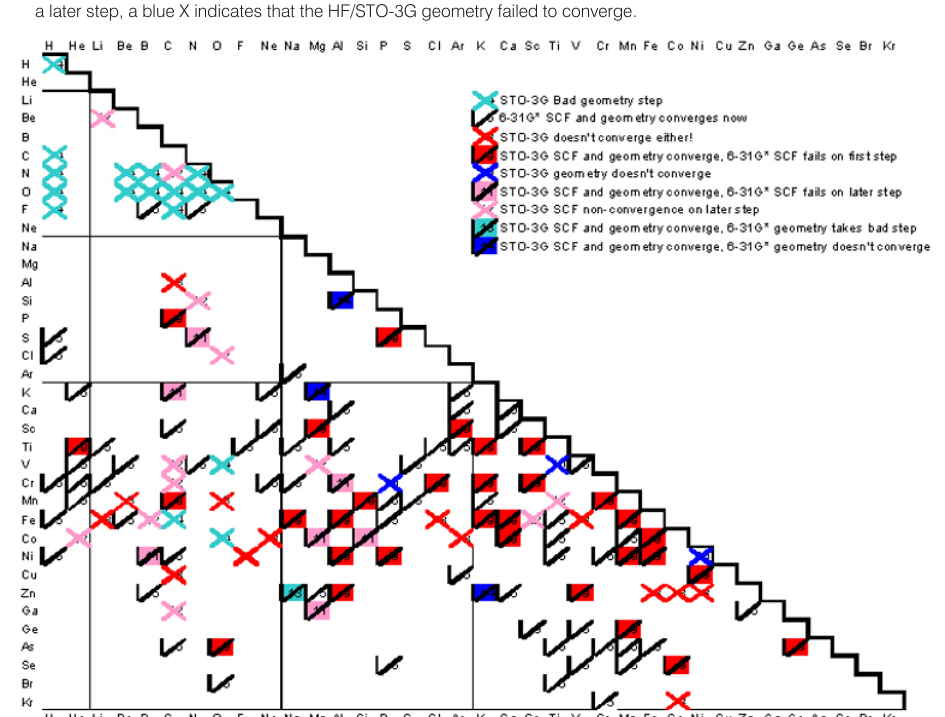
Figure 4. Results of running HF/STO-3G optimization, followed by HF/6-31G* optimization calculations on the Set 1-4 molecules using both the geometry and the wavefunction